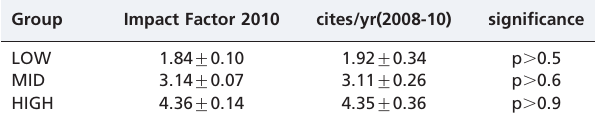
Table 2 - Average Impact Factor (2010) vs. calculated cites/ year for 10 journals per group as defined in Figure 1.